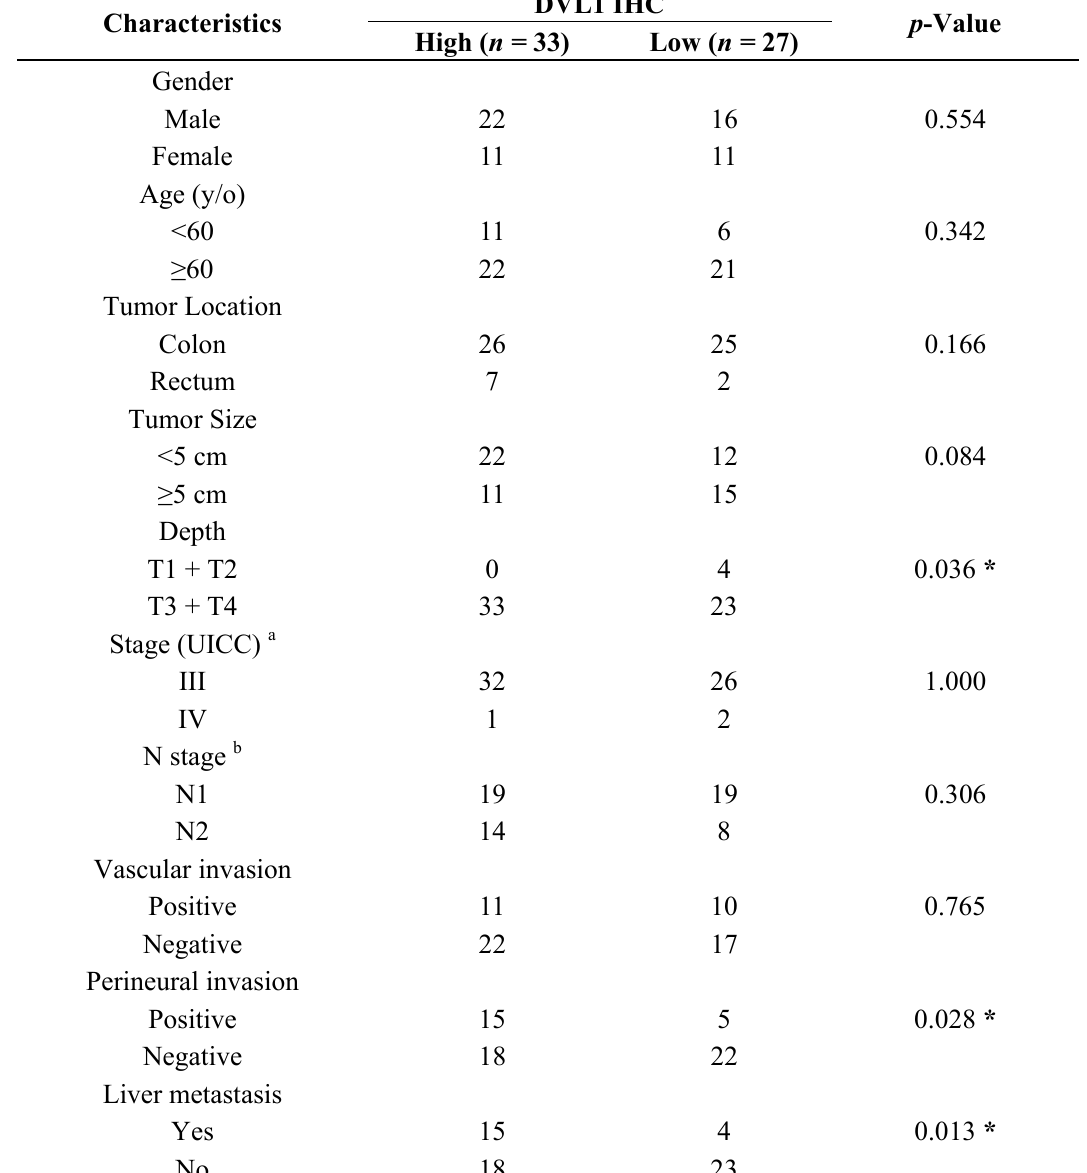
Table 5. Immunohistochemical staining of DVL1 in 60 CRC patients’ tumor